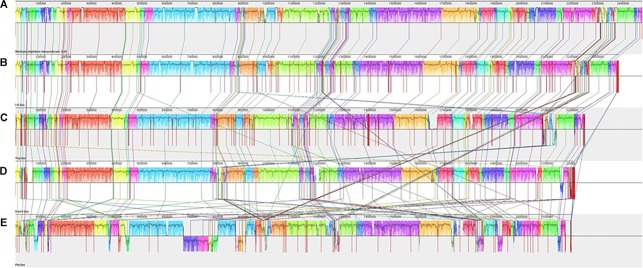
Alignment of the contigs of Methylacidiphilum spp. strains Fdl (B), Yel (C), Kam1 (D), and Phi (E) against the Methylacidiphilum fumariolicum SolV (A) chromosome using MAUVE 2.4.0. Vertical red lines indicate borders between contigs.